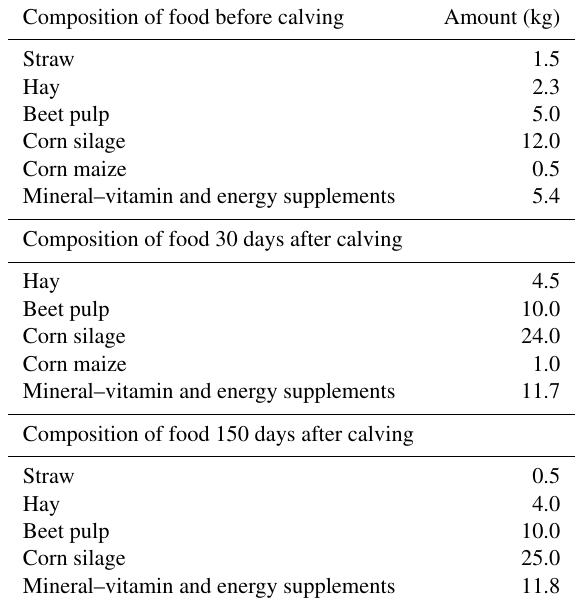
Table 1. Composition of daily meal of Holstein cows based on pro- duction